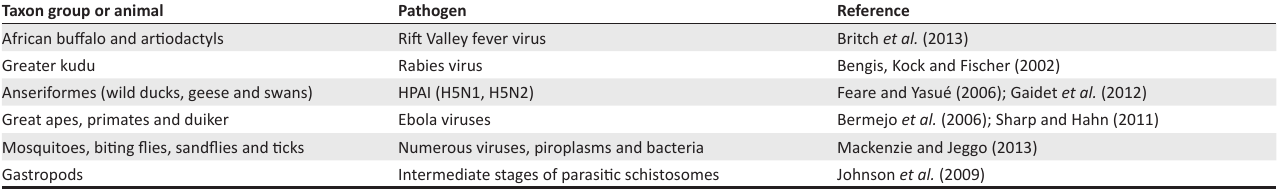
TABLE 1: Examples of wildlife taxa that are important hosts, carriers or vectors of human or domestic animal pathogens but not the maintenance hosts. Taxon group or animal